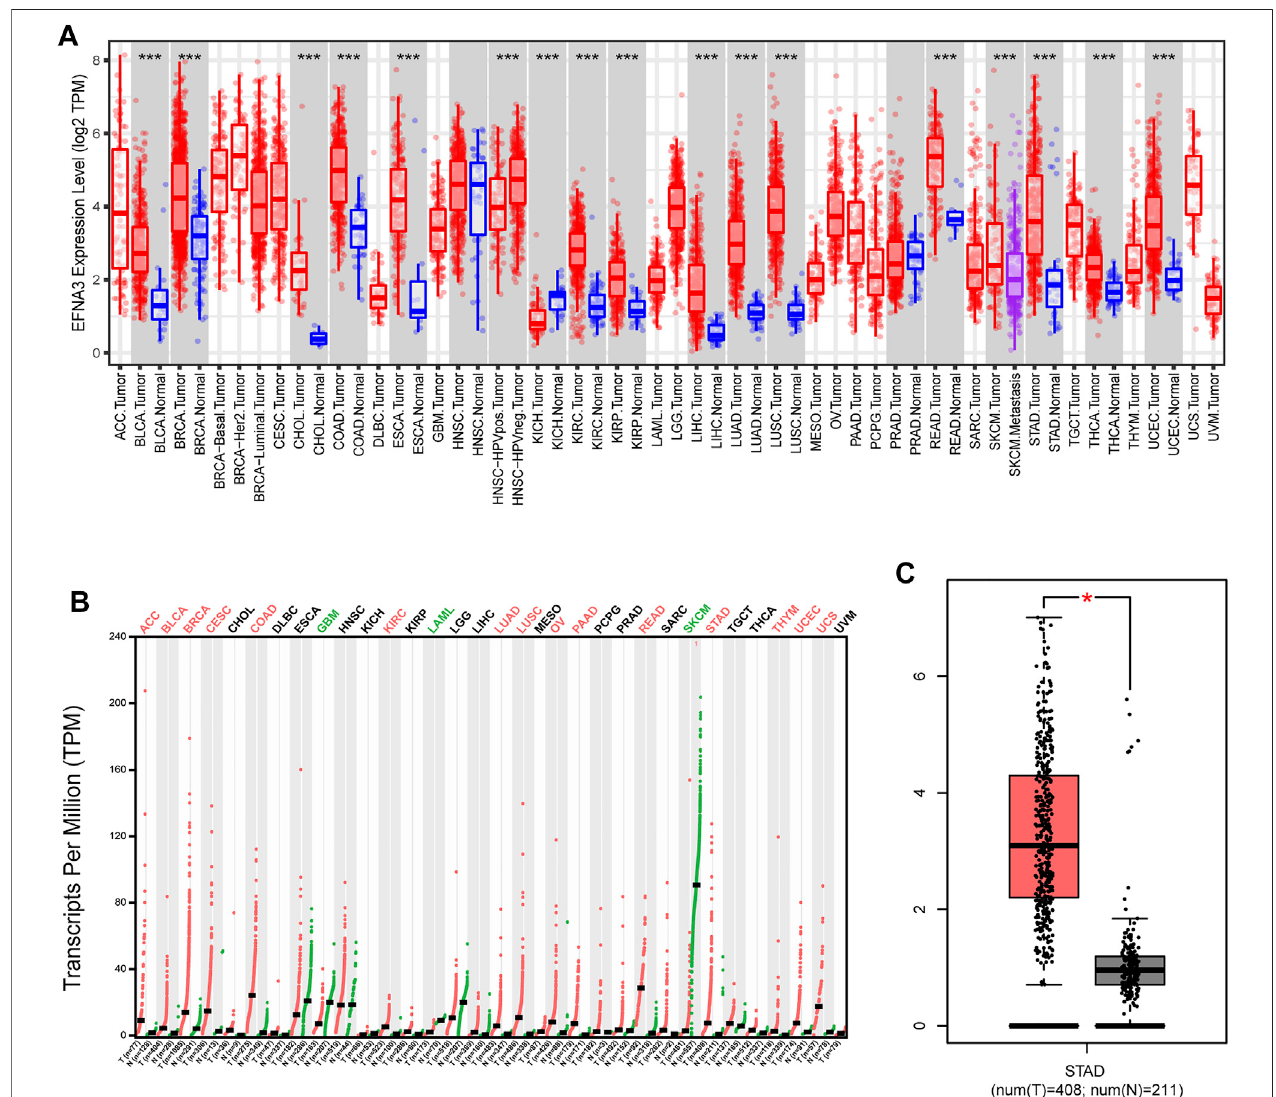
FIGURE1| EFNA3expressionlevelsindifferenttypesofhumancancers. (A) ExpressionofEFNA3indifferenttumortypesfromTIMER. (B) ExpressionofEFNA3in differenttumortypesinGEPIA2. (C)